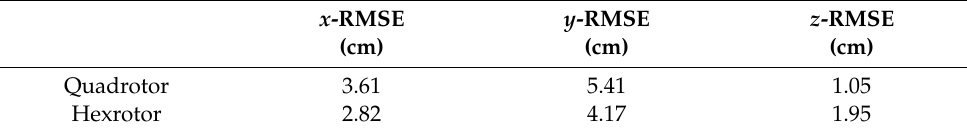
Figure 10. Experimental result of the ( a ) quadrotor and ( b ) hexrotor models, which achieved hovering capability within 8 s with 20 random initial states in the simulation flight test (position, velocity, attitude, and angular velocity). Table 2. Root mean square error of 1 min hovering of quadrotor and hexrotor at the point of